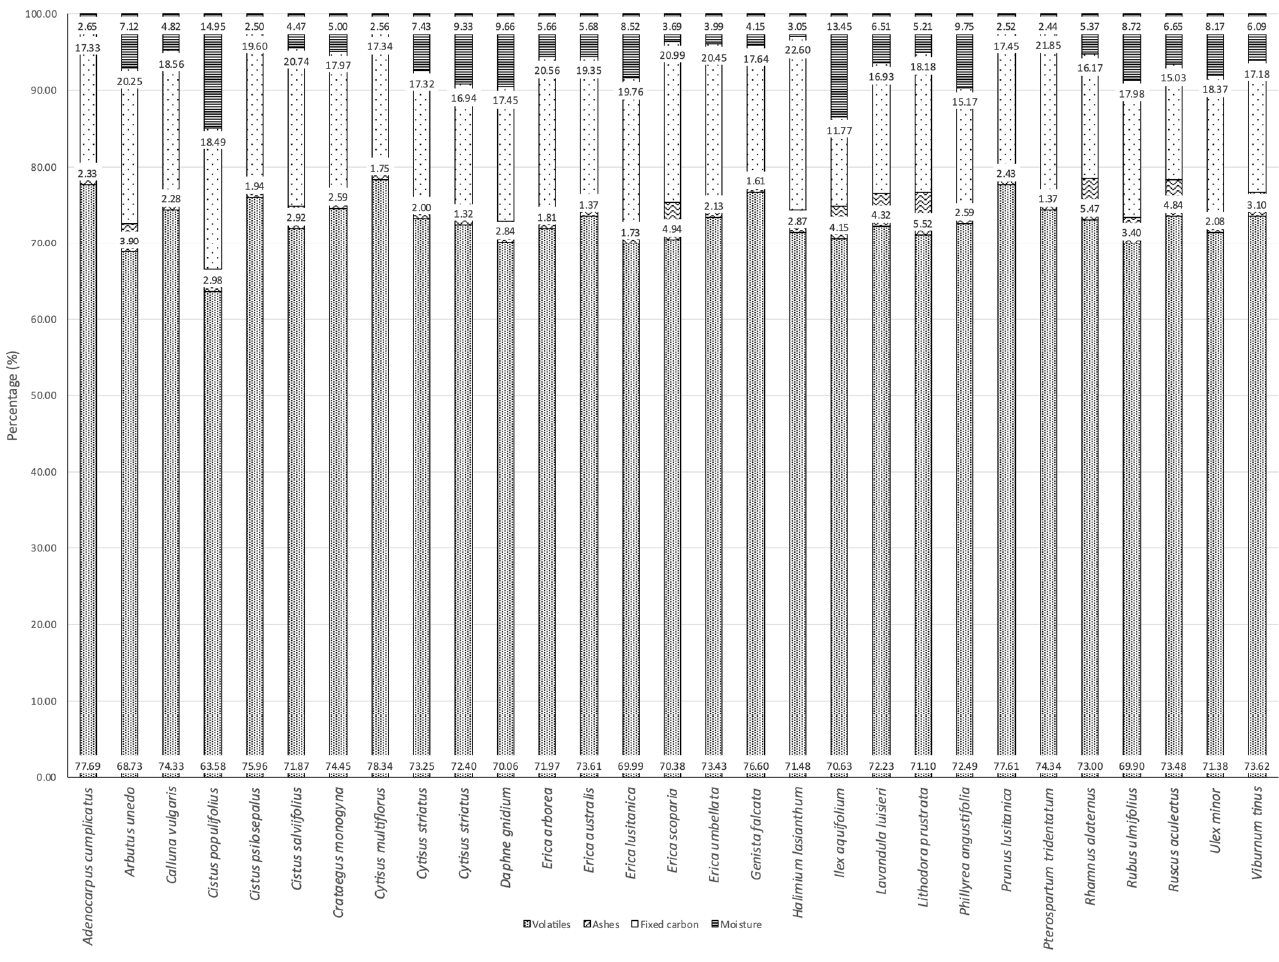
Figure 3. Results of the thermogravimetric analysis (TGA). The results are presented for the contents of ash, volatiles and fixed carbon.